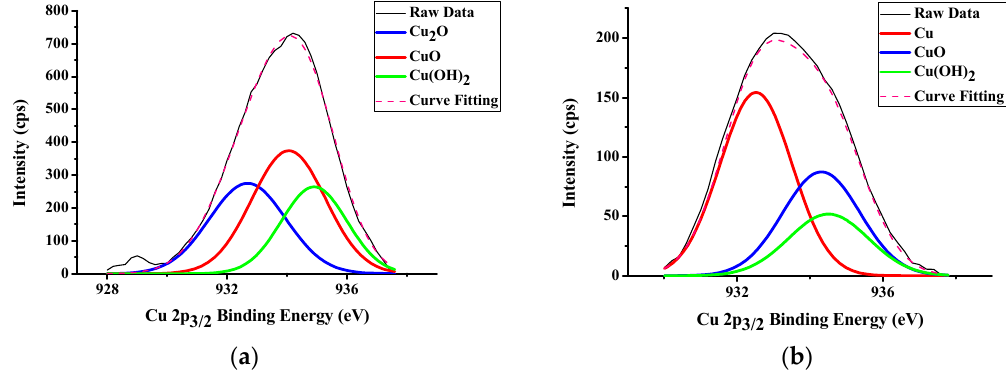
Figure 16. XPS results of Cu ( a ) Before Ar + O 2 plasma treatment ( b ) After Ar + O 2 plasma treatment.